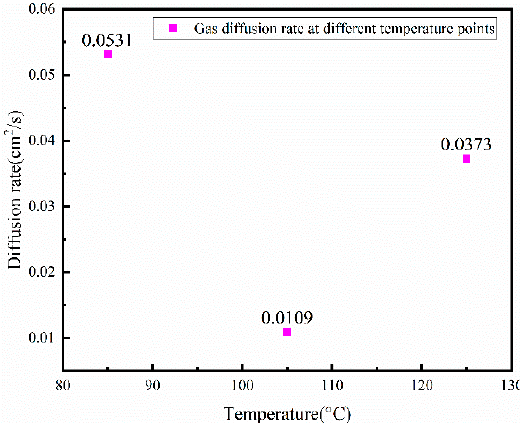
Figure 6. Outgassing rate at different temperature